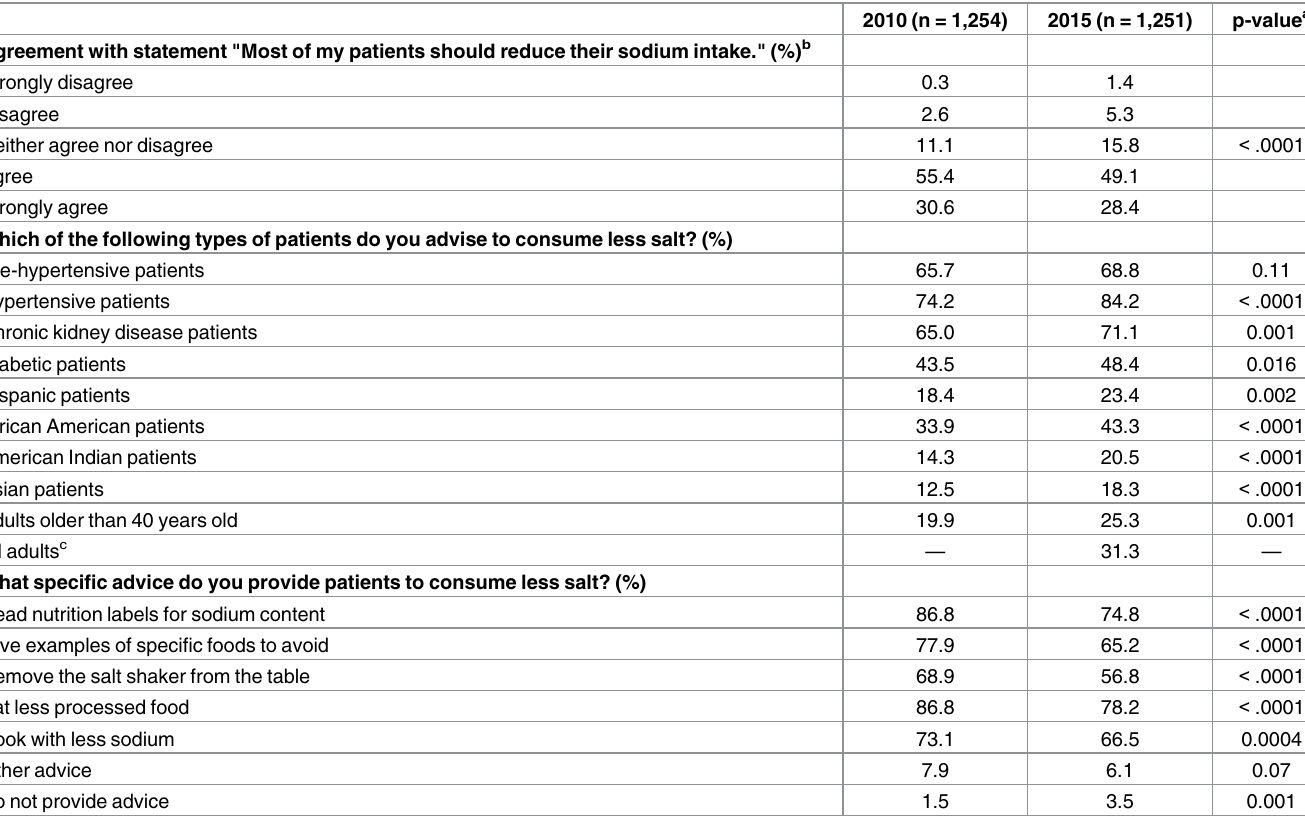
Table 3. Primary healthcare providers’ attitudes and counseling related to dietary sodium reduction, DocStyles 2010 and